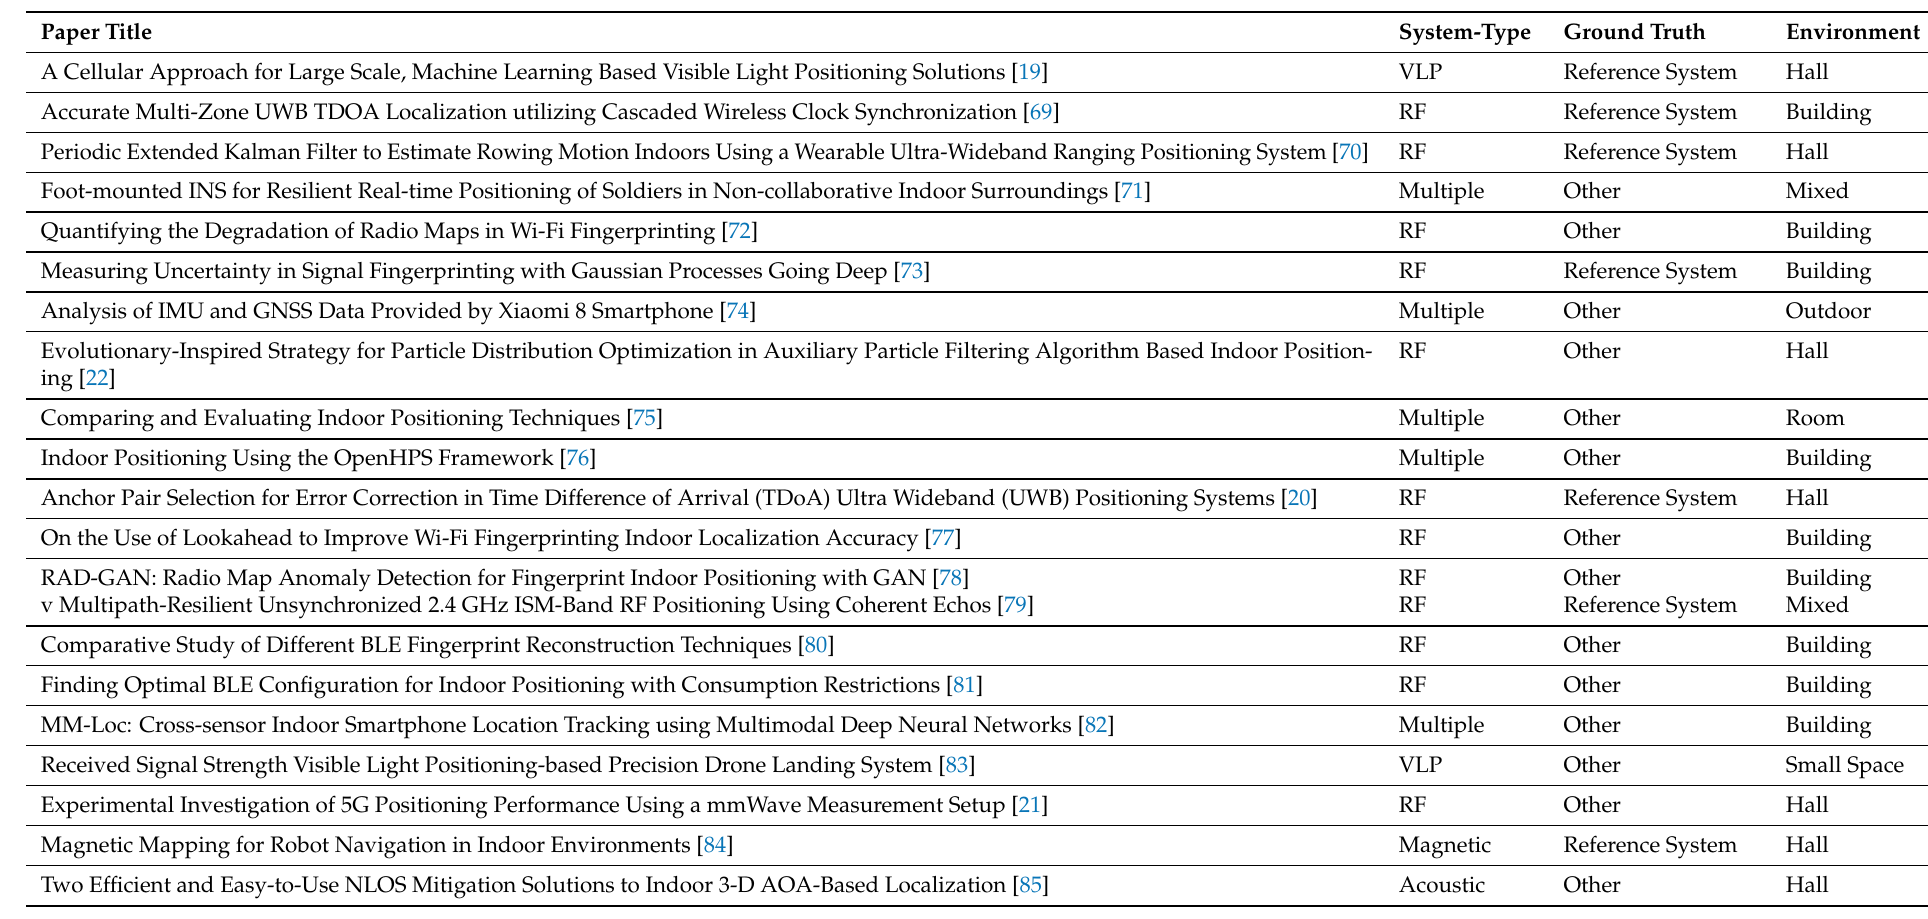
Table A1. Overview of the 33 publications from IPIN conference 2021, in which empirical test and evaluation of the absolute position accuracy were carried